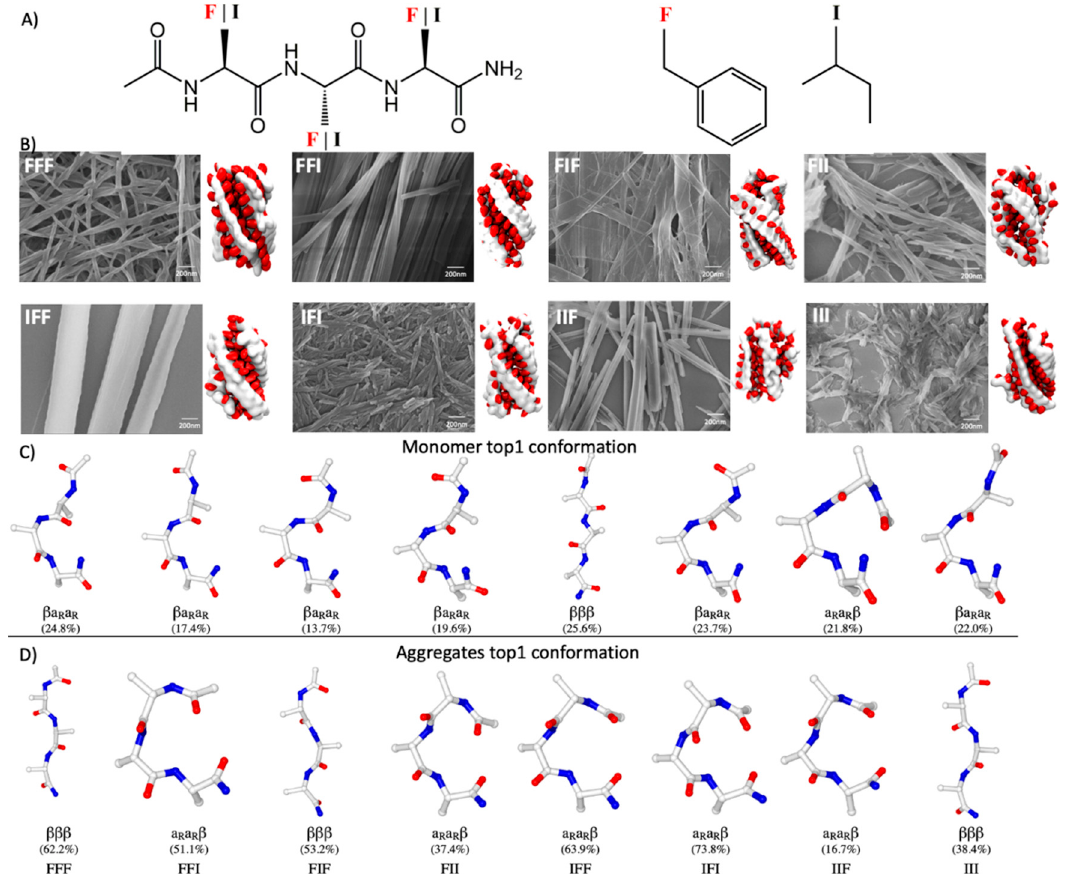
Figure 1. Sequence-dependent assembly structures of tripeptides containing Phe and Ile. ( A ) Schematic representation of the tripeptide sequences studied. ( B ) Assembly structures of tripeptides. Left: SEM images of tripeptide assemblies; right: a corresponding simulated assembled supramolecular structure. The backbones and sidechains of tripeptides are shown as white and red ellipsoids, respectively. Shown in ( C , D ) are representative structures and corresponding probabilities of the most populated conformations of tripeptides in solution states and in assembled states, respectively. For simplicity, only backbone and C β atoms are shown.